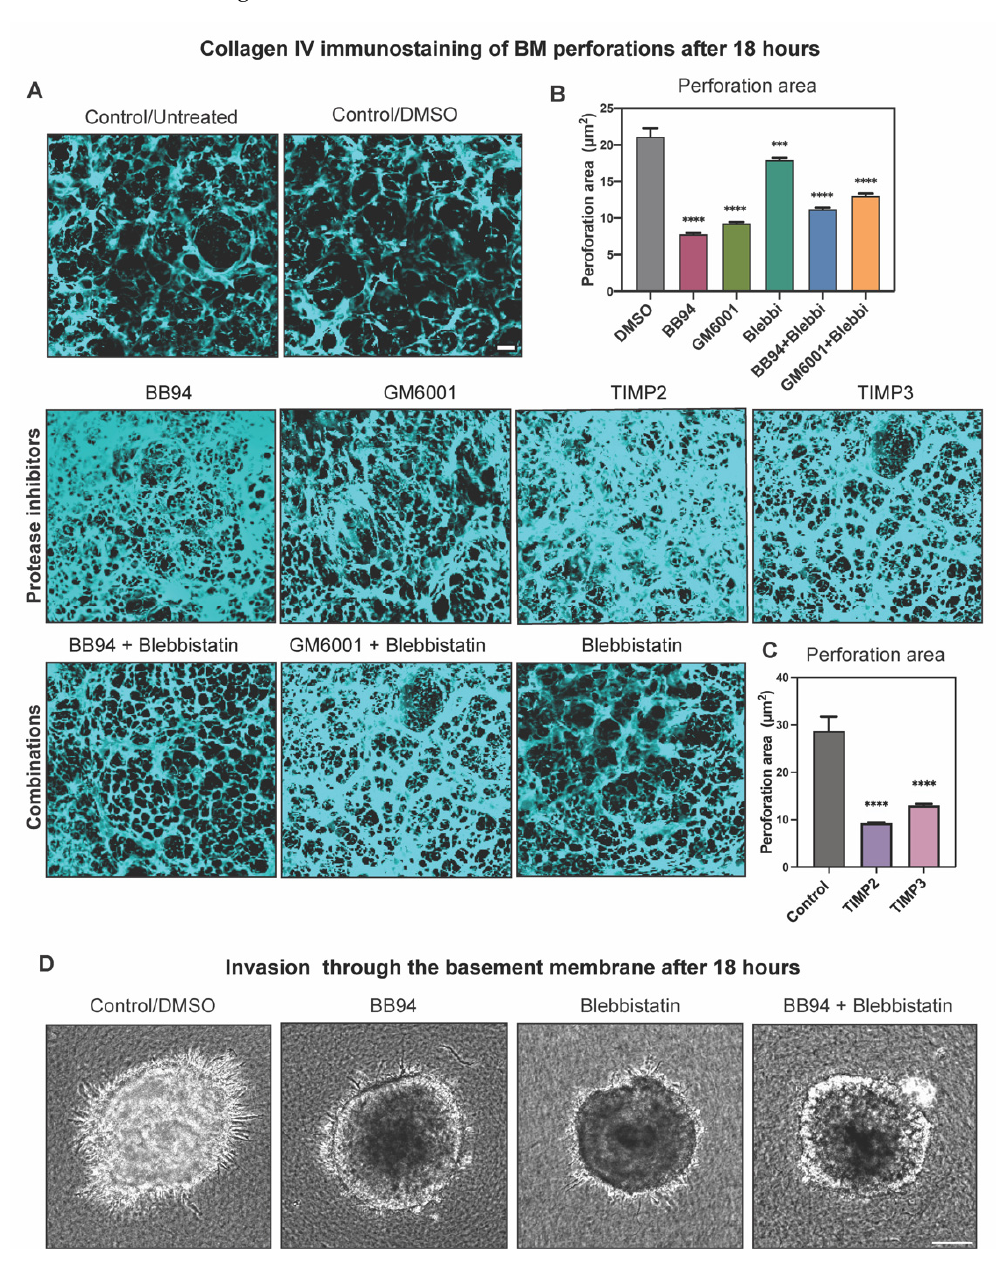
Figure 4. Contributions of proteolysis and myosin II contractility to basement membrane perforation. ( A ) Maximum intensity projection images of the basement membrane surrounding the spheroid after 18 h treatment with the following protease inhibitors or combinations of inhibitors: control (untreated), control (DMSO), BB94, GM6001, TIMP2, TIMP3, blebbistatin, BB94 + blebbistatin, or GM6001 + blebbistatin. ( B ) Quantification of basement membrane perforation areas after treatment with the indicated small molecule inhibitors during 18 h cancer cell invasion. ( C ) Quantification of perforation area in comparisons of TIMP2 and TIMP3 versus control. ( D ) Brightfield images of spheroids shown in panel A treated with small-molecule inhibitors of proteases (BB94), myosin II (blebbistatin), or a combination of BB94 and blebbistatin. **** p < 0.0001; *** p < 0.0007. These graphs and images are based on pooled data from at least 3 independent experiments, each including at least 3 spheroids per experiment, all of which showed similar results. Scale bars: ( A ), 10 µ m; ( D ), 100 µ